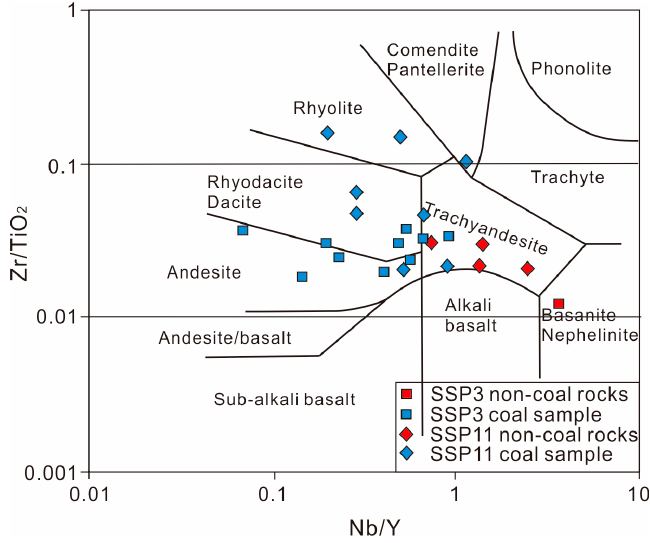
Figure 10. Plots of Zr/TiO 2 vs. Nb/Y ratios in samples from the No. 11 and No. 3 coal seams, Sangshuping mine, Weibei